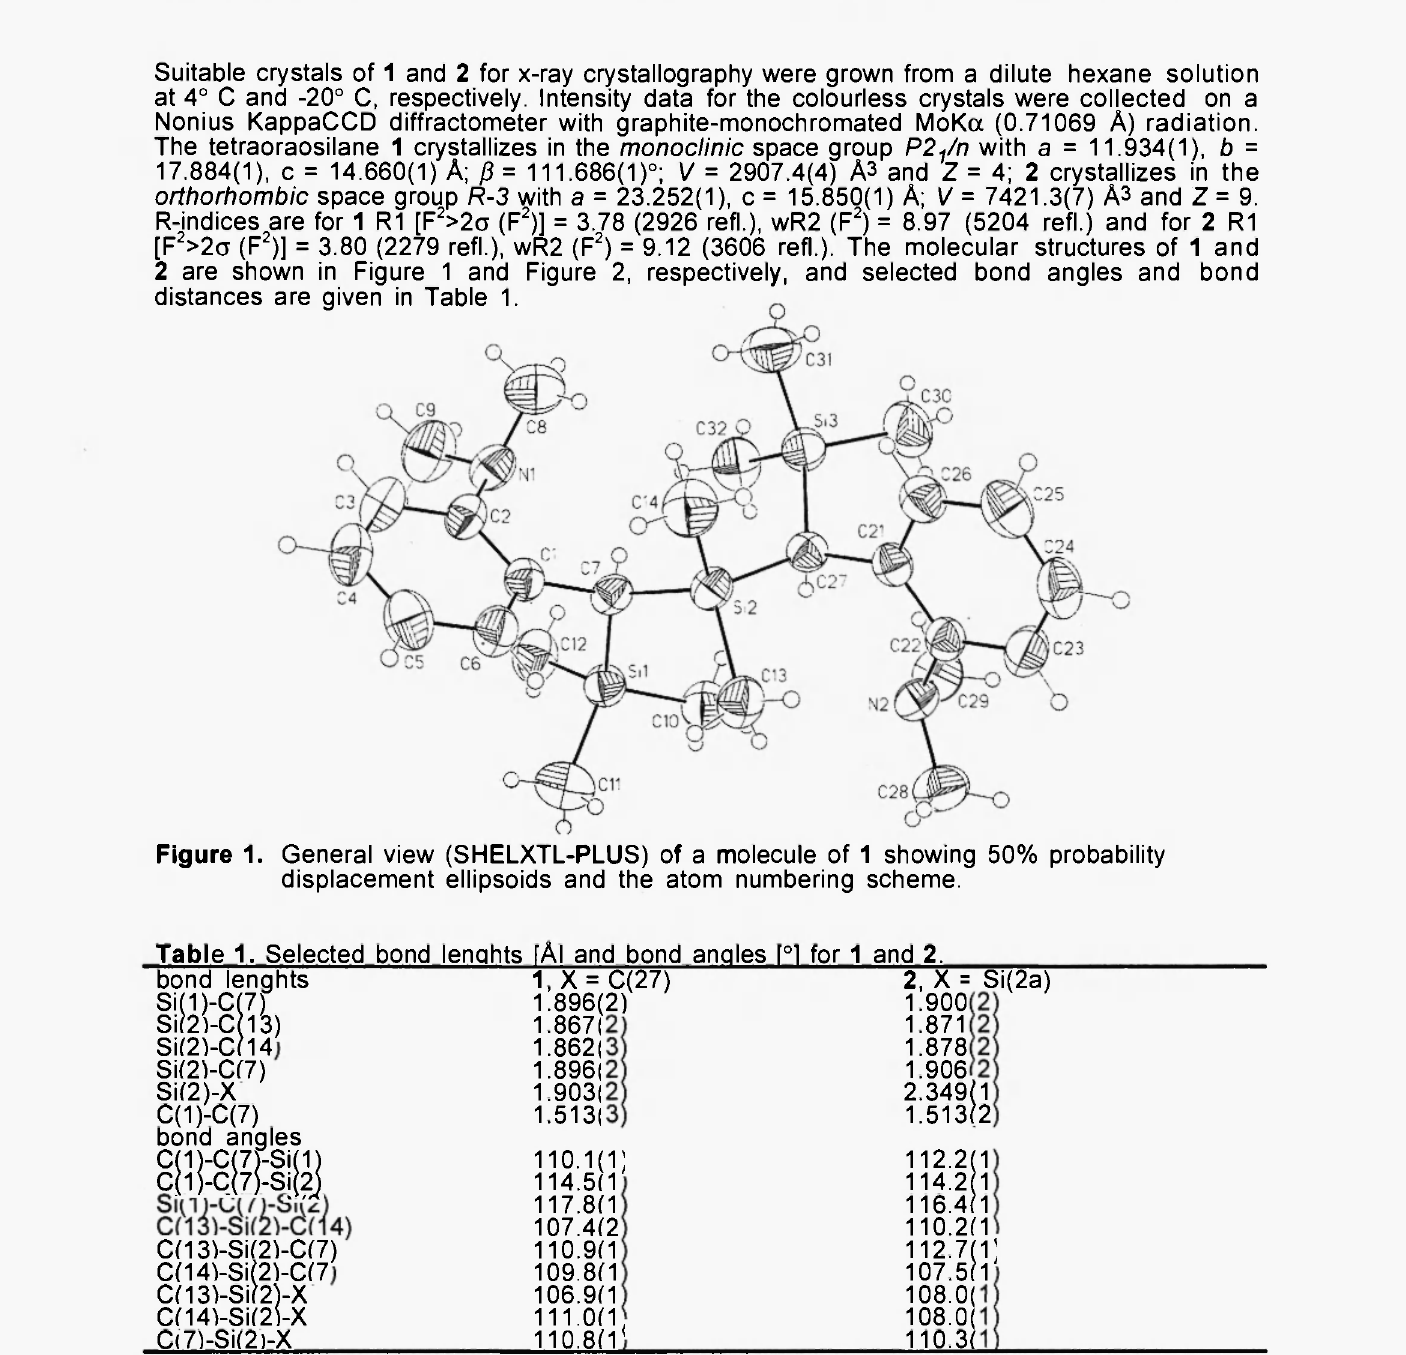
Figure 1. General view (SHELXTL-PLUS) of a molecule of 1 showing 50% probability displacement ellipsoids and the atom numbering scheme. Table 1. Selected bond lenqhts [Al and bond angles f°1 for 1 and 2. bond lenghts